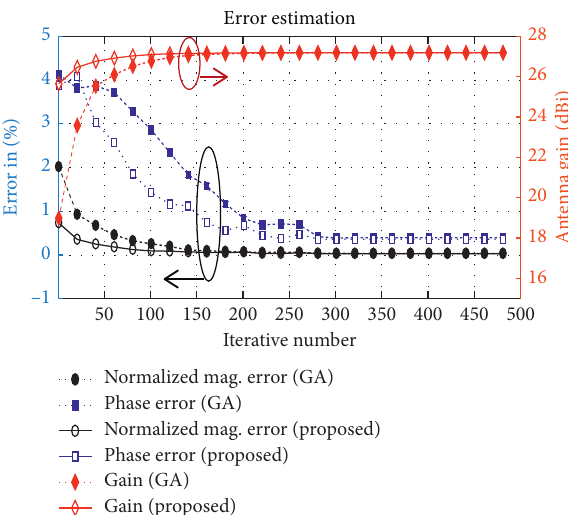
Figure 5: Comparison of convergence analysis results between conventional and modified GAs (Figure 2).